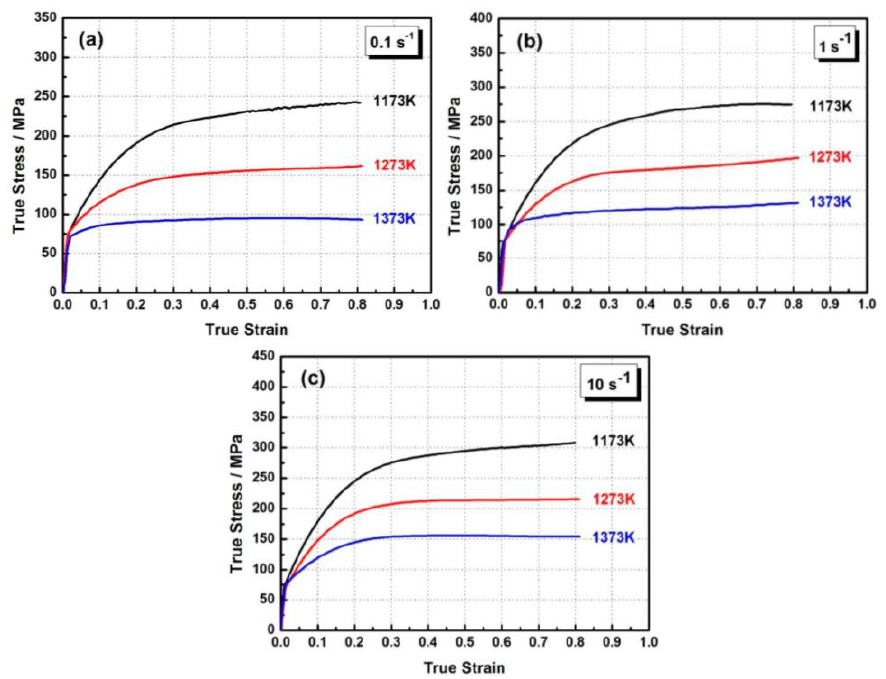
Figure 1. Representative true stress-strain curves of the studied steel under different deformation temperatures with strain rates ( a ) 0.1 s −1 ; ( b ) 1 s −1 ; and ( c ) 10 s −1